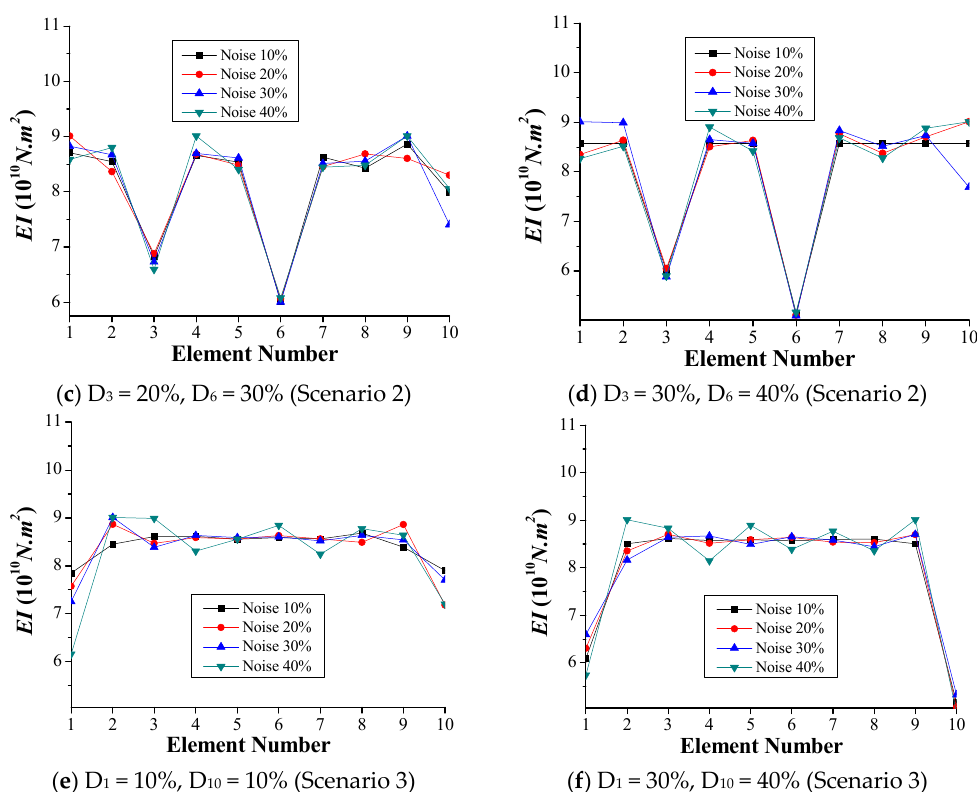
Figure 19. Simulation results of calculated EI with different noise levels.